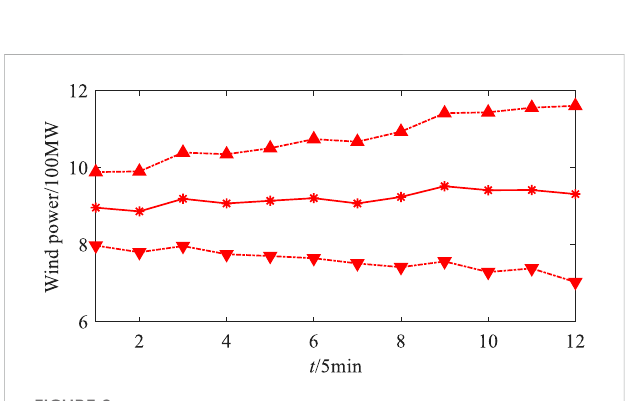
FIGURE 2 Forecast expectation and forecast interval of wind power.